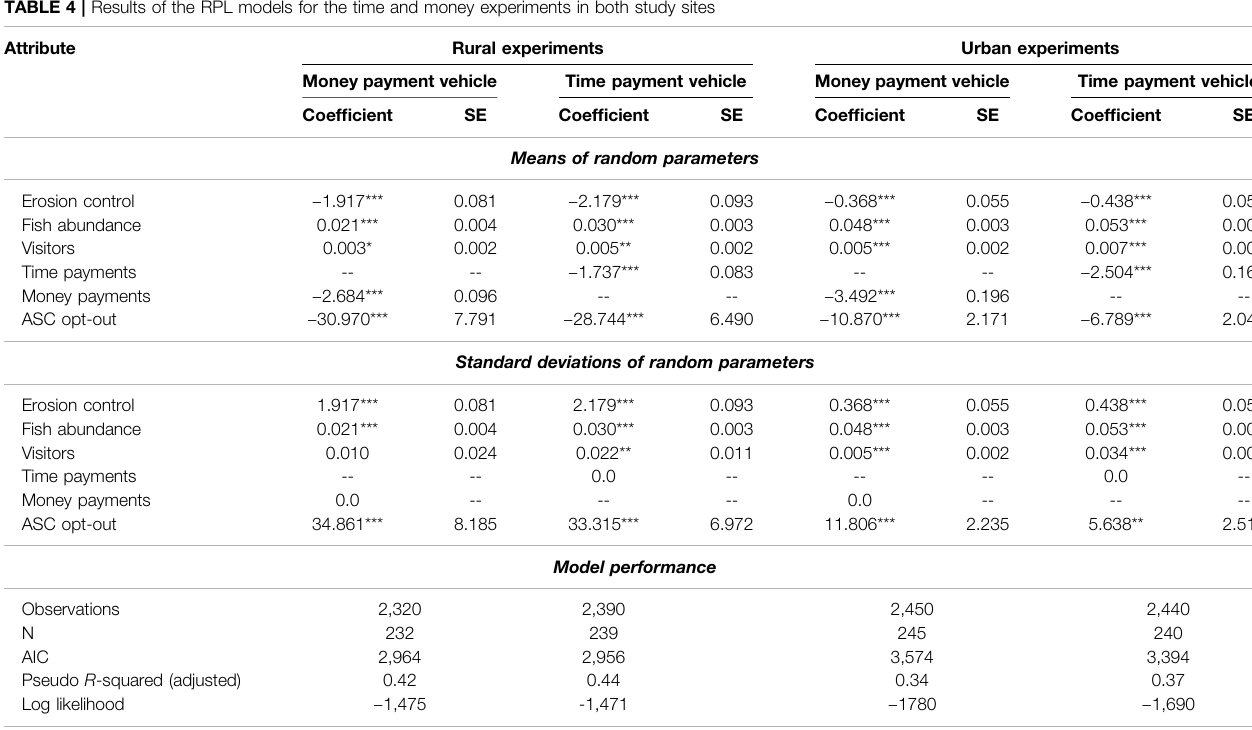
TABLE 4 | Results of the RPL models for the time and money experiments in both study sites